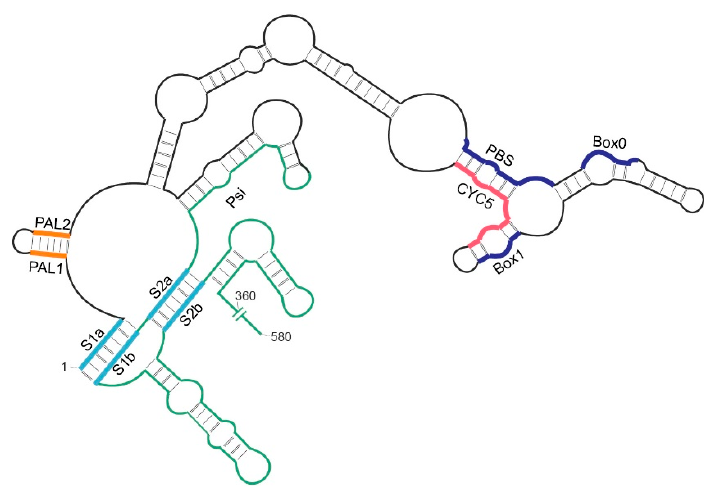
Figure 1. Schematic representation of the 5 (cid:48) -end of Ty1 gRNA containing cis -acting sequences: palindromes (PAL1 and PAL2; orange) involved in RNA dimerization, primer binding site (PBS) and short boxes (Box0, Box1; dark blue) that anneal cellular tRNA iMet and 5 (cid:48) cyclization site (CYC5; pink). The region containing the proposed packaging signal (+230 − 580) is shown in green. The strands forming the stems (S1 and S2) of the pseudoknot motif are shown in